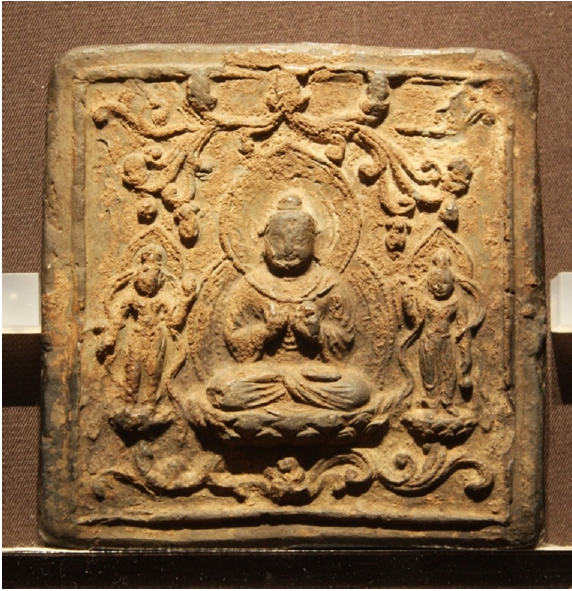
Figure 12. Clay Buddha, Tang Dynasty, ca. 627, 8.8 × 8.8 cm, Nara National Museum, Japan. [©Photograph by Lim, 2019].